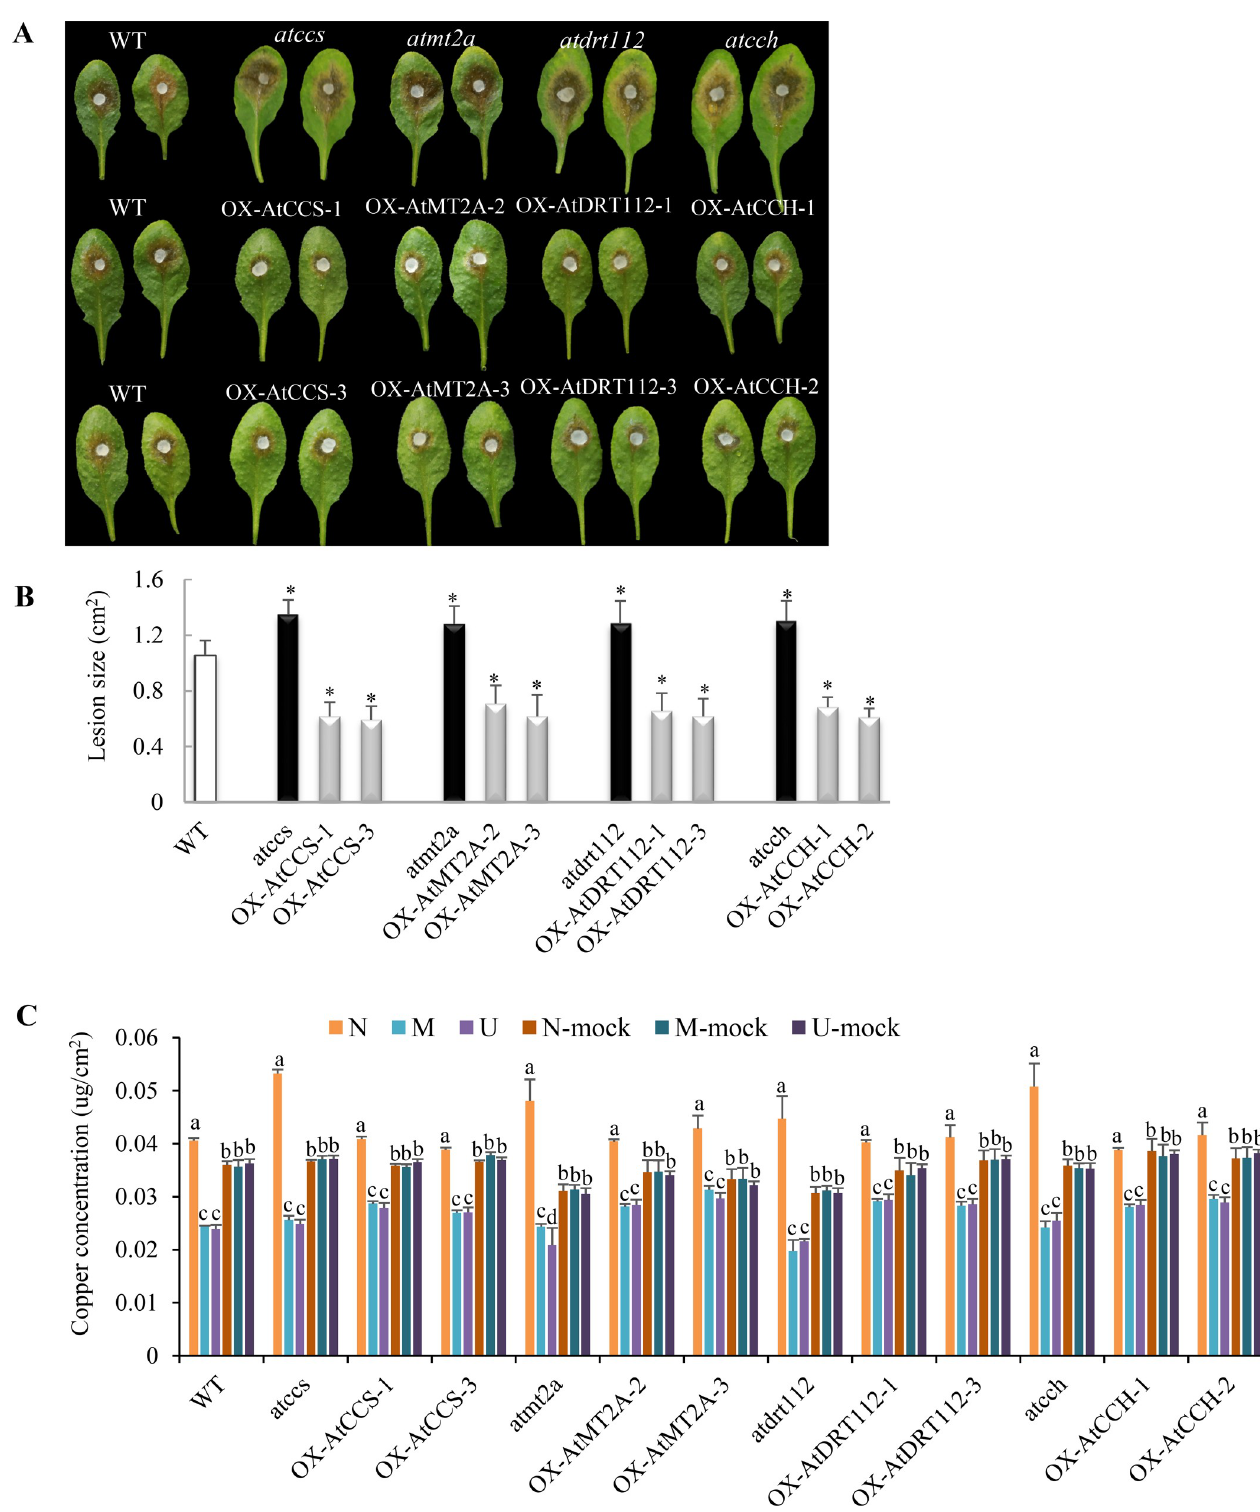
Fig 2. Copper ion homeostasis genes promote resistance to S . sclerotiorum in Arabidopsis thaliana . (A) Disease symptoms in A . thaliana wild-type line Col-0 (WT), T-DNA mutants ( atccs , atmt2a , atdrt112 and atcch ) and overexpression lines (OX-AtCCS, OX-AtMT2A, OX-AtDRT112 and OX-AtCCH) corresponding to copper ion homeostasis genes at 24 hpi with S . sclerotiorum wild-type strain 1980. (B) Quantitation of Lesion sizes in (A). Error bars indicate